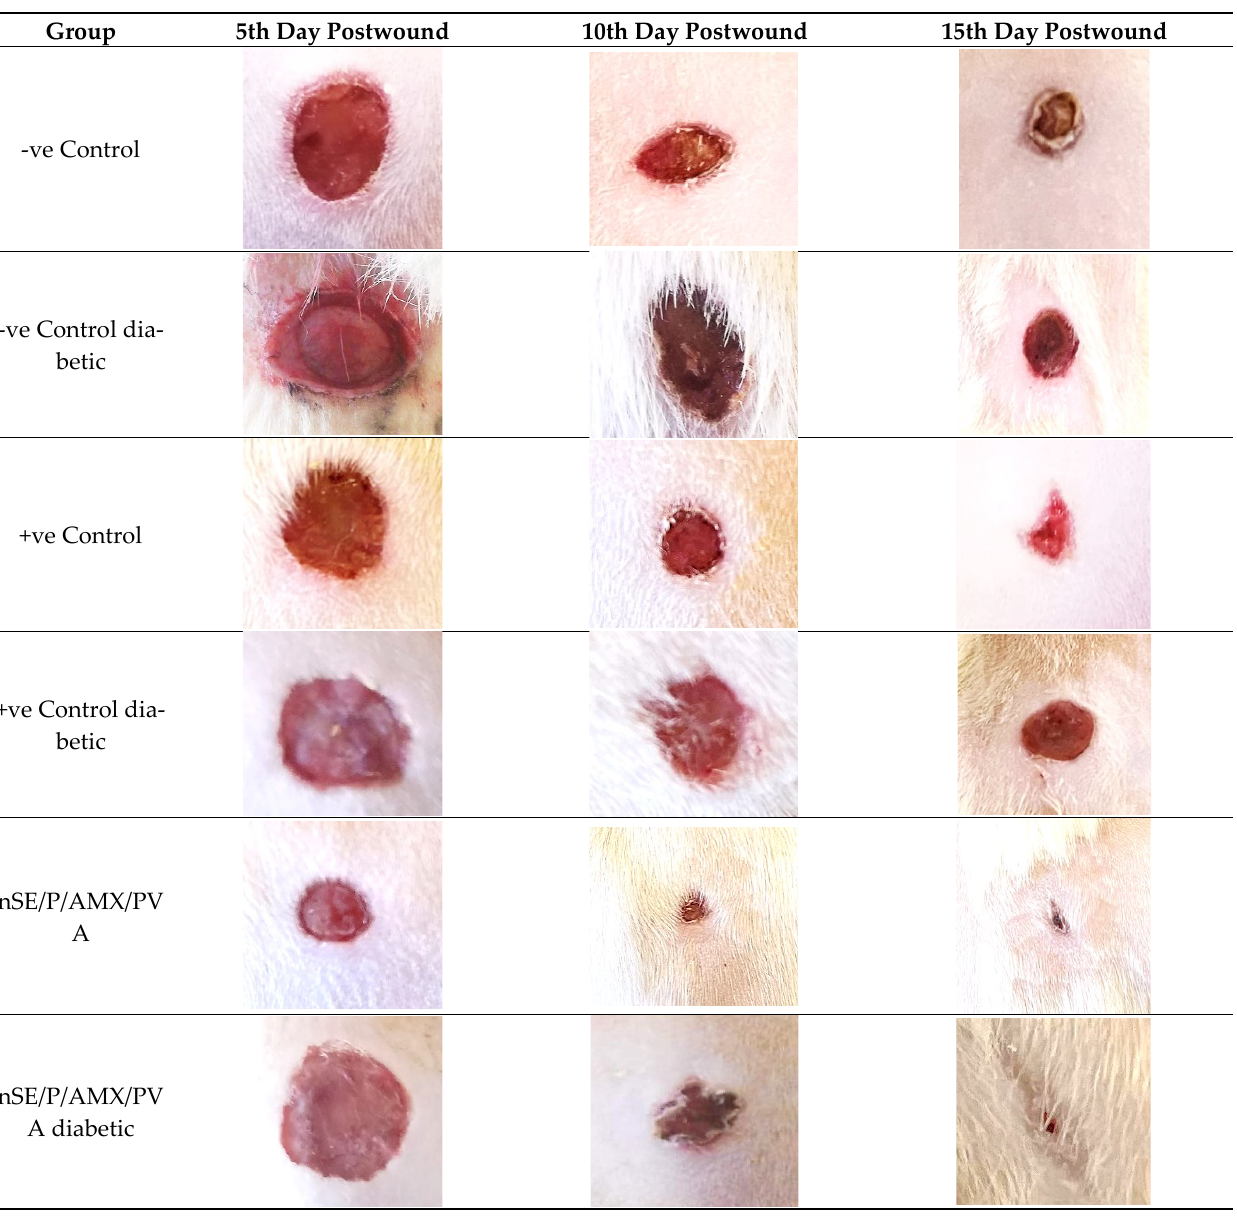
Figure 6. Morphological evaluation of nSE/P/AMX/PVA-treated bacterial wound skin infection in normal rats, showing rapid gradual wound healing at different time intervals, referring to the controls.